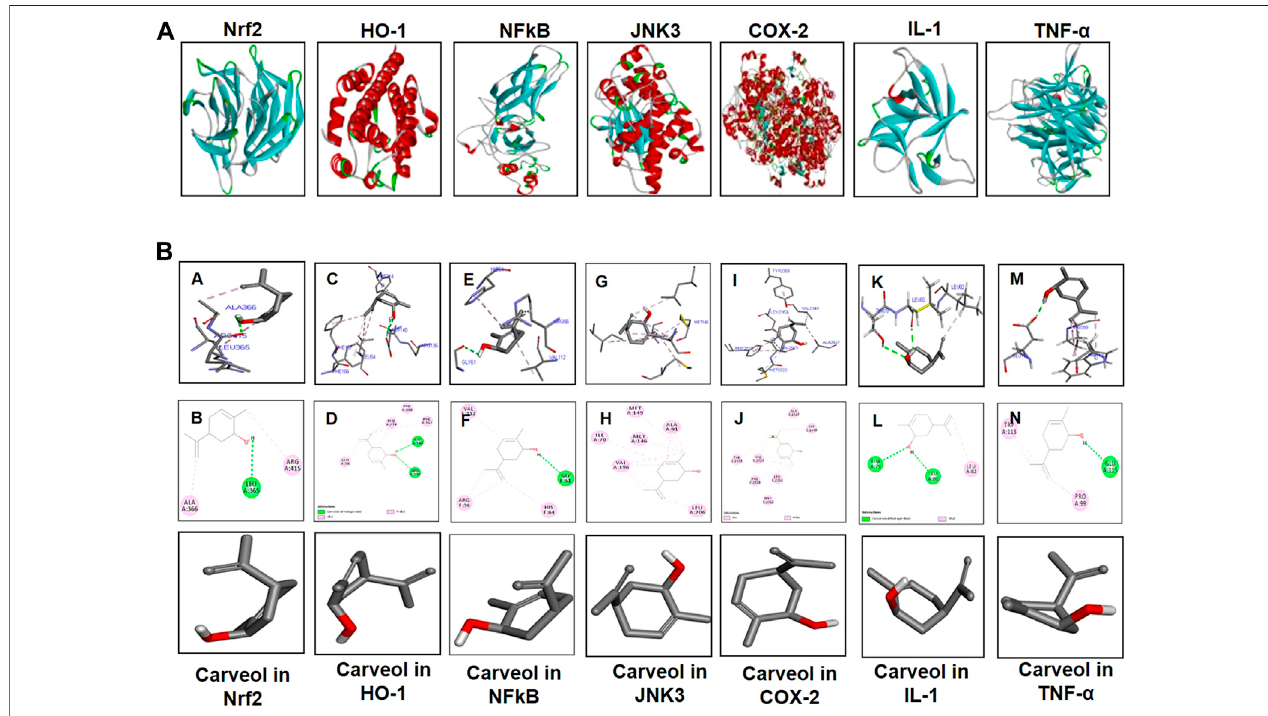
Figure9| Computational anddockinganalyses; (A) Tertiary structures oftheproteins Nrf2,HO-1,NF κ B,JNK3,COX-2,TNF- α ,and IL-1 β . (B) Thedockingresults show the best pose of carveol that fi tted to Nrf2, HO-1, NF κ B, JNK3, COX-2, TNF- α , and IL-1 β . The post-docking analysis was visualized using DSV in both 2D and 3D poses. The interaction between carveol and Nrf2 is shown in the panels (A, B) , HO-1 in the panels (C, D) , NF κ B in the panels (E, F) , JNK in panels (G, H) , COX-2 in the panels (I,J) ,IL-1inthepanels (K,L) ,andTNF- α inthepanels (M,N) .The3Dposesareshowninthepanels (A,C,E,G,I,K,M) andthe2Dinthepanels (B,D,F,H, J, L, N) . Abbreviations: iNOS, inducible nitric oxide; TNF- α , tumor necrosis factor; IL-1 β , interleukin; HO-1, heme oxygenase 1, COX-2,